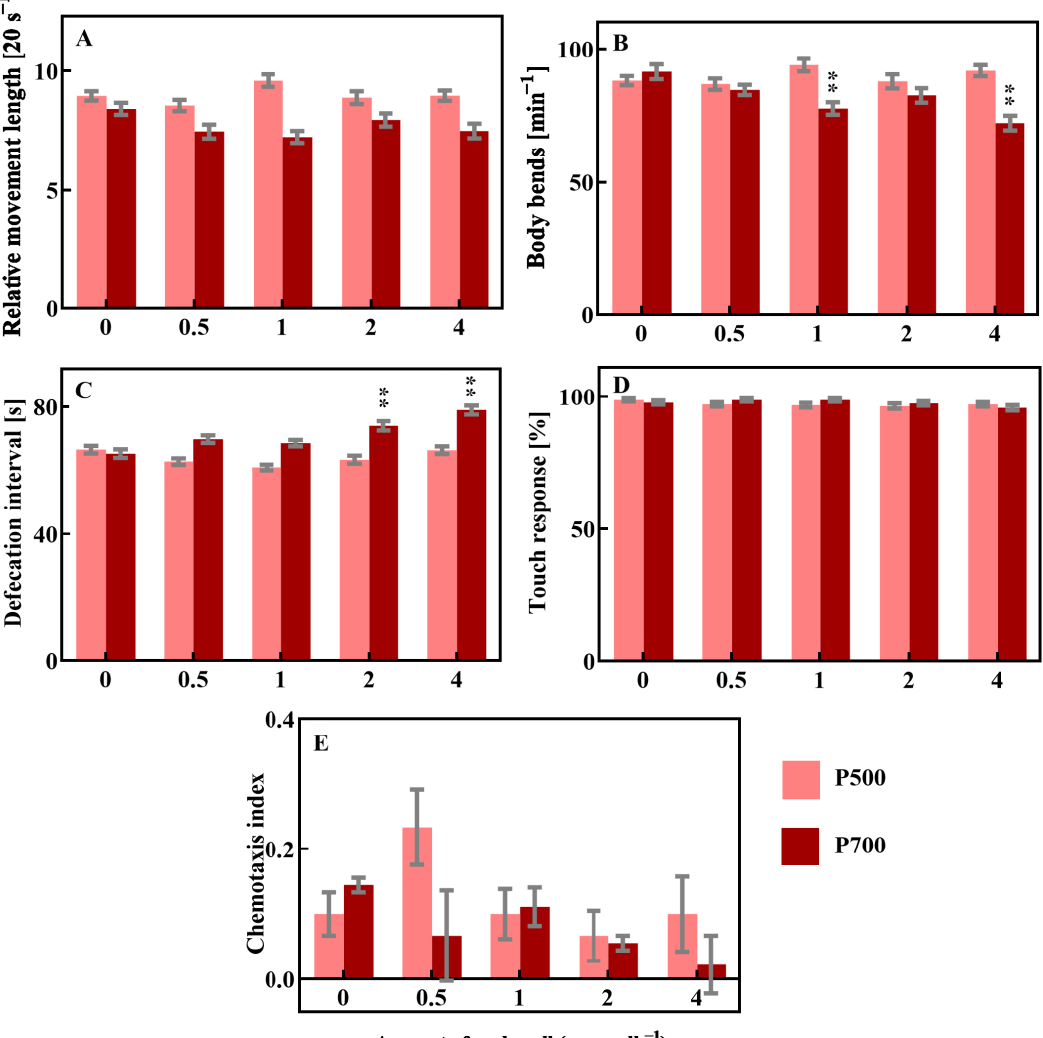
Figure 2. ( A – E ) Neurobehavior of Caenorhabditis elegans after 24 h exposure to washed biochar particles of 500 °C and 700 °C (P500 and P700). ** means p < 0.01, which indicates a significant difference.